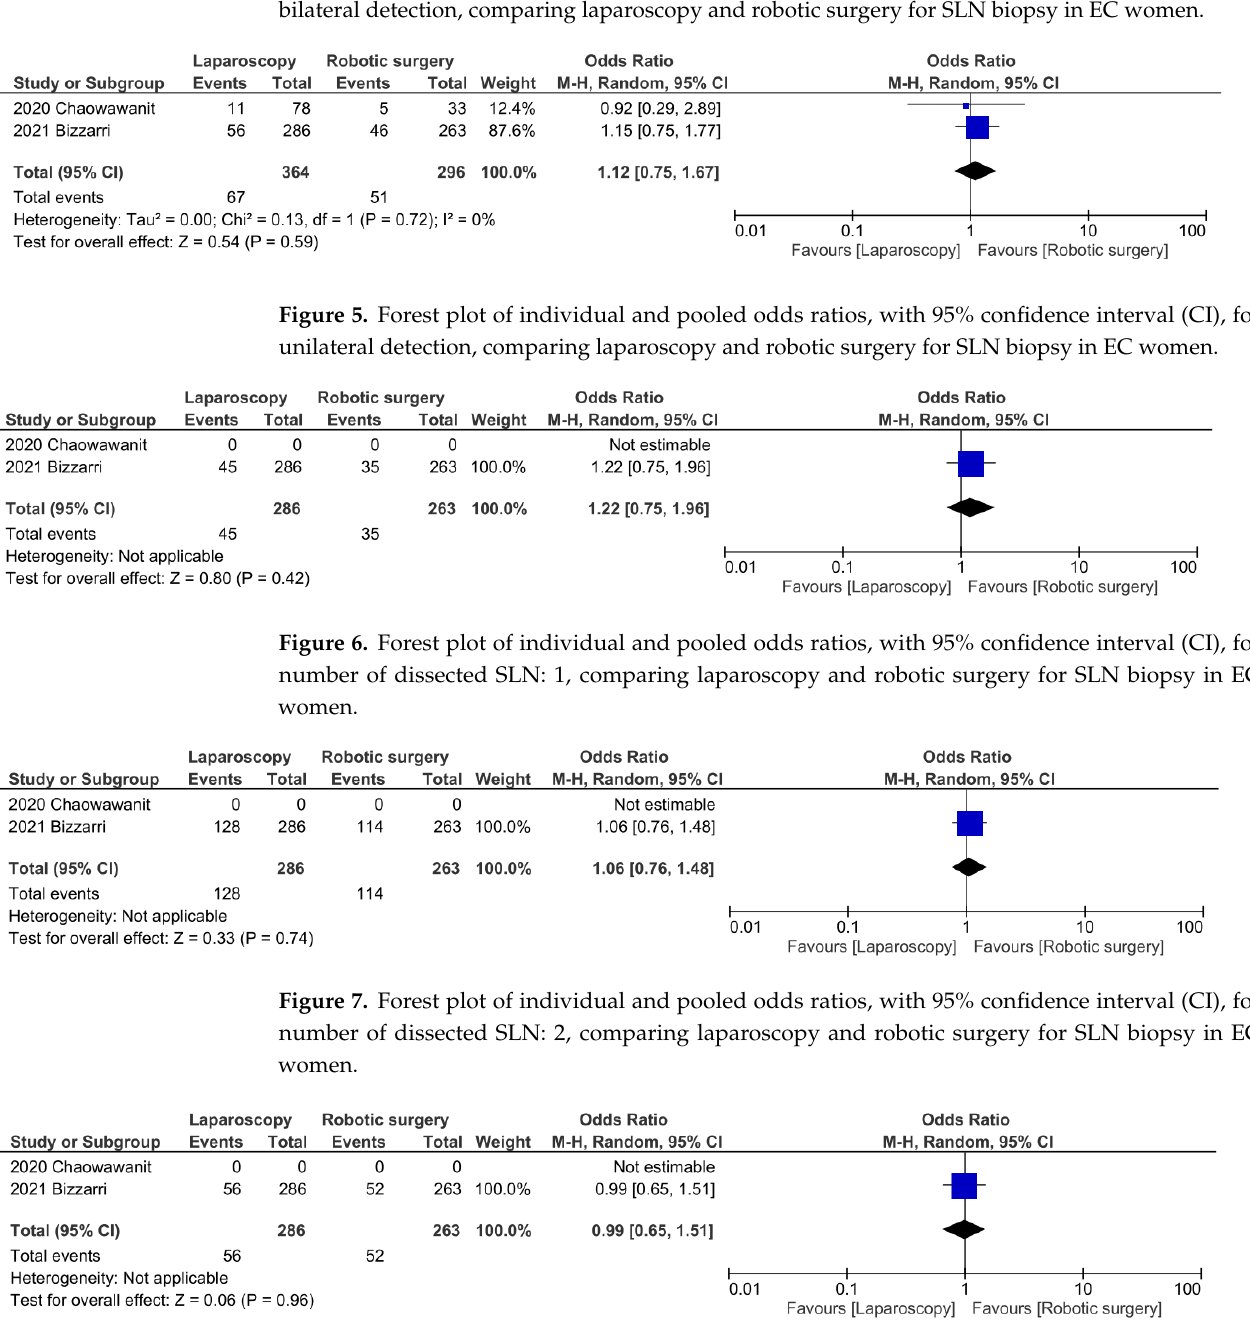
Figure 8. Forest plot of individual and pooled odds ratios, with 95% confidence interval (CI), for number of dissected SLN: 4, comparing laparoscopy and robotic surgery for SLN biopsy in EC women.